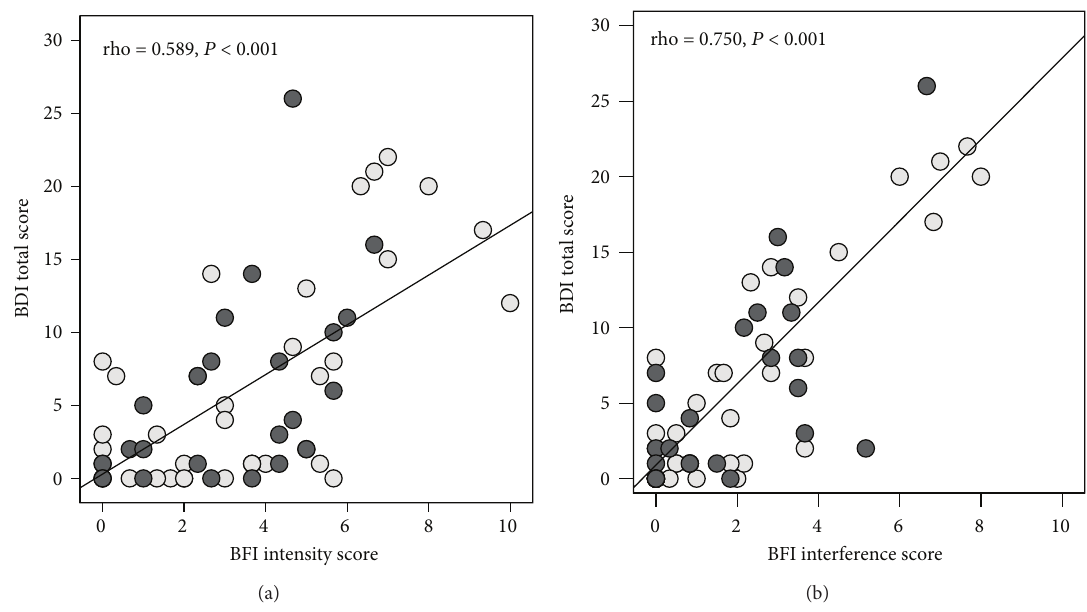
Figure 2: Relationship between BDI and BFI intensity scale (a) or BFI interference scale (b) in patients with chronic hepatitis C. Note . BDI: Beck Depression Inventory; BFI: Brief Fatigue Inventory; BFI intensity score = mean of three items (fatigue at present, at its usual level, and at its worst); e previous IFN- 𝛼 treatment; I treatment-na¨ıve.